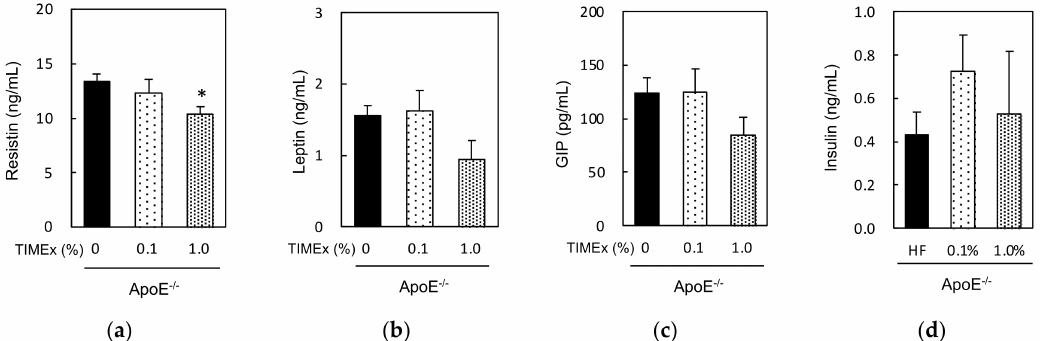
Figure 3. Effects of the consumption of a hot-water extract of thinned immature mangoes (TIMEx) on the atherosclerotic lesions of apolipoprotein E-deficient (ApoE − / − ) mice. ( a ) Oil Red O-stained whole aortas and ( b ) the mean areas of the aortic atherosclerotic lesions, determined using ImageJ software (V. 1.44p, NIH, Bethesda, MD, USA). The data are mean ± SEM; n = 9. There were no significant differences vs. the control group (0% TIMEx).